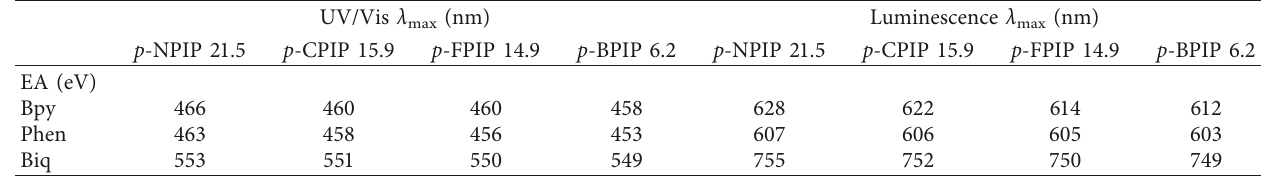
Table 2: Electronic data for ruthenium complexes aerated in acetonitrile at